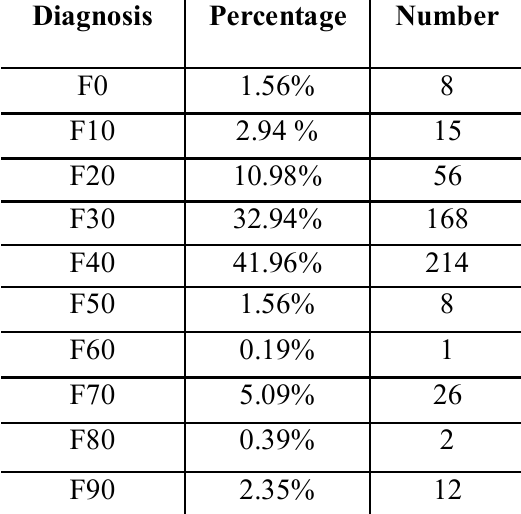
Table: 4: Distribution of Patient